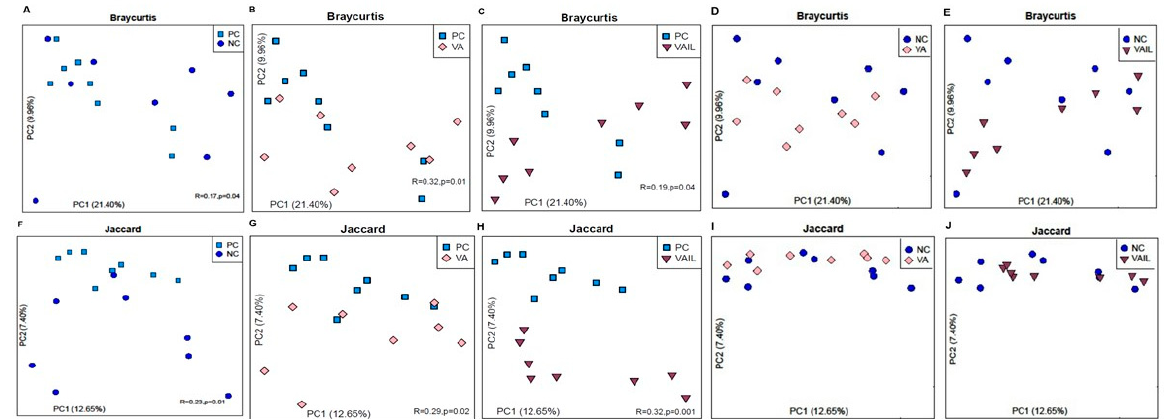
Figure 4. Beta diversity of colon bacterial community in pigs fed with very low protein diets supplemented with isoleucine (Ile) at NRC and valine (Val) above NRC levels, or a combination of the two. Principal coordinates analysis (PCoA) based on ( A – E ) Bray–Curtis and ( F – J ) Jaccard. ( A , F ) NC vs. PC, ( B , G ) VA vs. PC, ( C , H ) VAIL vs. PC, ( D , I ) VA vs. NC; ( E , J ) VAIL vs. NC. ANOSIM was used to test the difference of beta diversity between diet treatments. PC: positive control, standard protein diet; NC: negative control, very low protein diet containing first four limiting amino acids (i.e., lysine, methionine, threonine, and tryptophan) at NRC (2012) levels; VA: NC containing Val above NRC level; IL: NC containing Ile at NRC level; VAIL: NC containing Val above NRC and Ile at NRC levels. Each node represents an individual pig. n =